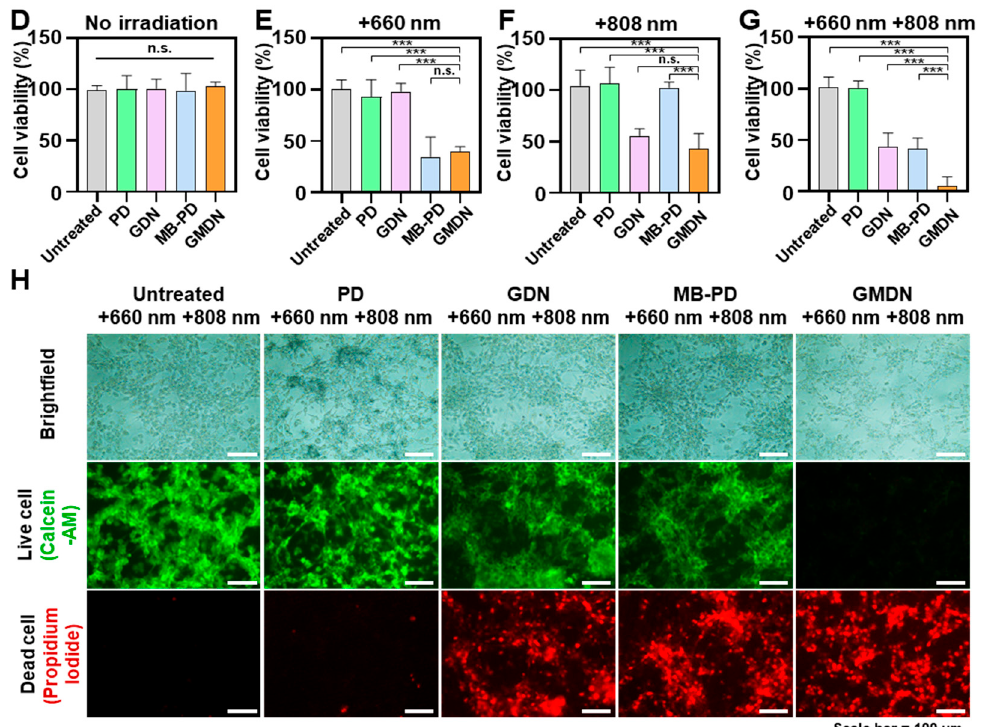
Figure 4. In vitro photodynamic and photothermal effects of GMDN. Various formulations were applied to CT26 cells for 4 h, followed by 660-nm or 808-nm irradiation. ( A ) ROS generation in the cells was evaluated by H2DCFDA detection upon 660-nm irradiation. ( B ) Upon 808-nm NIR laser irradiation, heat generation was observed by thermo-imaging. ( C ) The temperature was monitored during irradiation. ( D – G ) Anti-cancer efficacy was evaluated by measuring cell viability under no irradiation ( D ), 660-nm irradiation ( E ), 808-nm irradiation ( F ) and dual light irradiation ( G ). ( H ) The anti-cancer efficacy was visualized by live and dead cell imaging (n.s., not significant; *** p < 0.001).